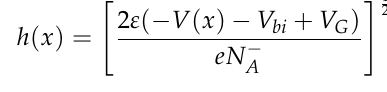
Figure 3. The state of the depletion layer of the C ‐ O BDD SGFETs when the drain ‐ source voltage is low and the gate leakage current is flowing. At 95 °C, when the drain ‐ source voltage is small, the depletion layer is not sufficiently formed and a gate leakage current is generated.